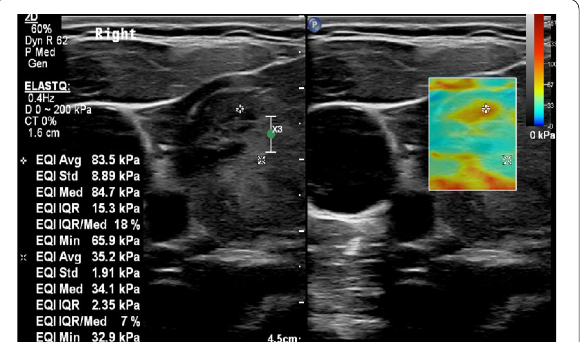
Fig. 3 A 14.5-year-old female patient with FNAB-proven papillary thyroid carcinoma. Transverse scan for left lobe of the thyroid gland obtained by linear probe. On the right side of the figure, grayscale US shows a hypoechoic nodule with irregular margin which was assessed as a suspicious nodule on grayscale US. On the left side of the figure, SWE displays a heterogeneous color elasticity signal with central high SWE areas (red); mean SWE was 83.5 kPa